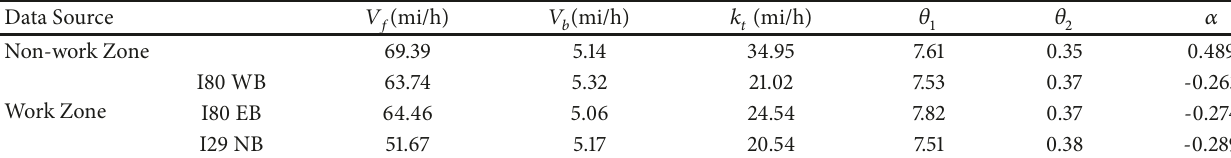
Table 3: Parameters of logistic speed-density